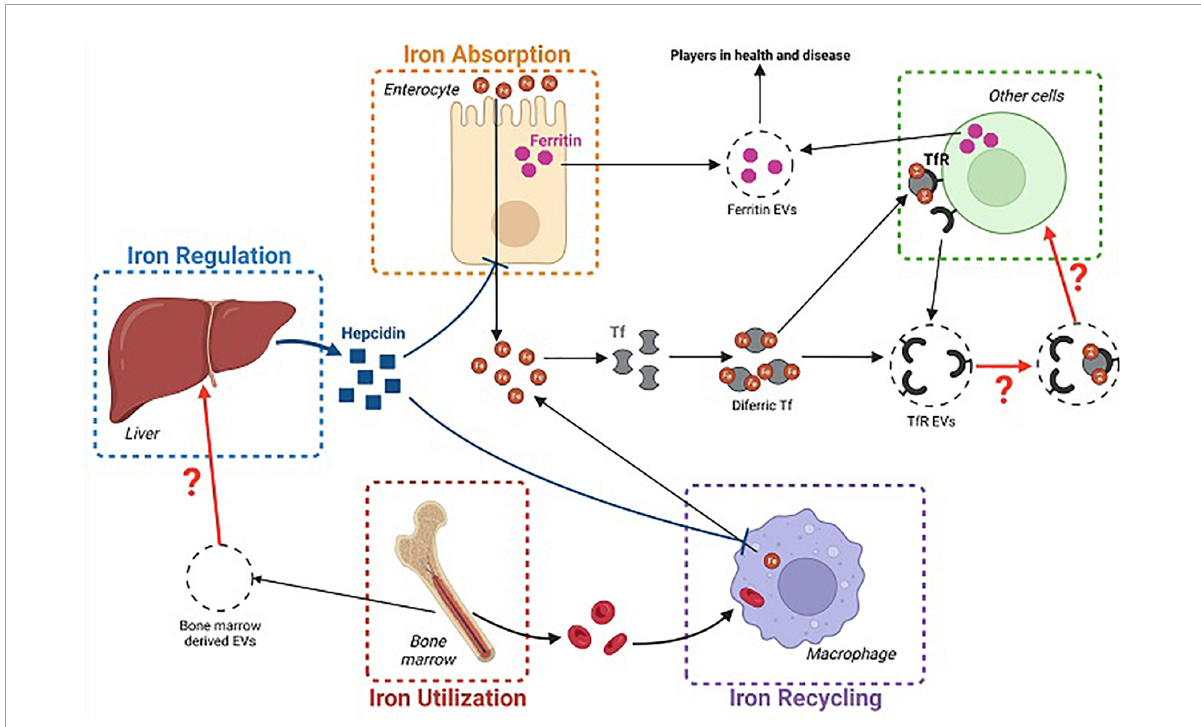
FIGURE1 Schematic representation of the potential implication of extracellular vesicles (EVs) in iron homeostasis. This figure illustrates the possible involvement of (1) Transferrin carrying EVs (TFR EVs) in iron delivery to host cells, (2) Ferritin EVs in mediating disease symptoms, and (3) Bone marrow-derived EVs in affecting hepcidin release. ©Created with BioRender.com.